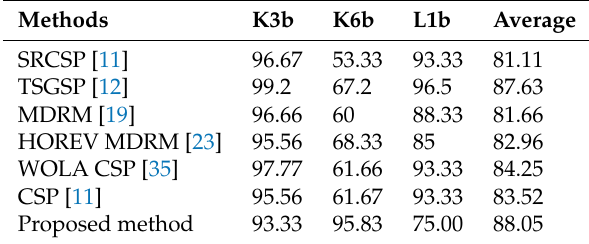
Table 6. The comparison of performance accuracy (%) with sophisticated methods (based on BCI III-IIIa).